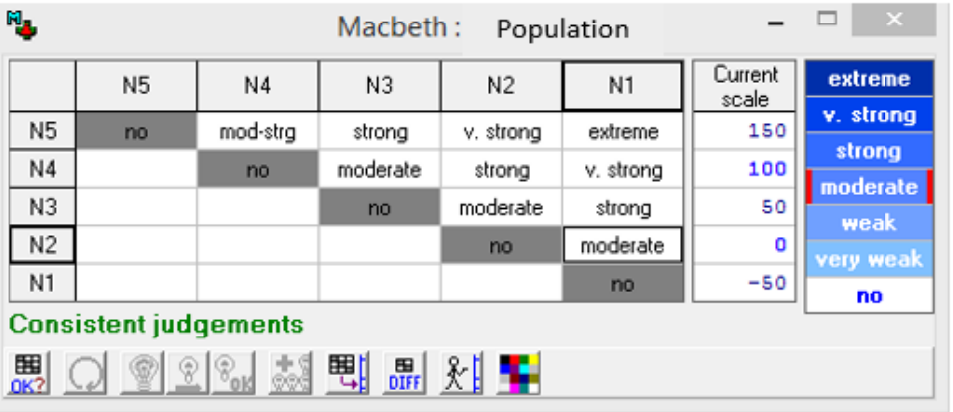
Figure 4. Anchoring functions of FPV 1—population of the immediate